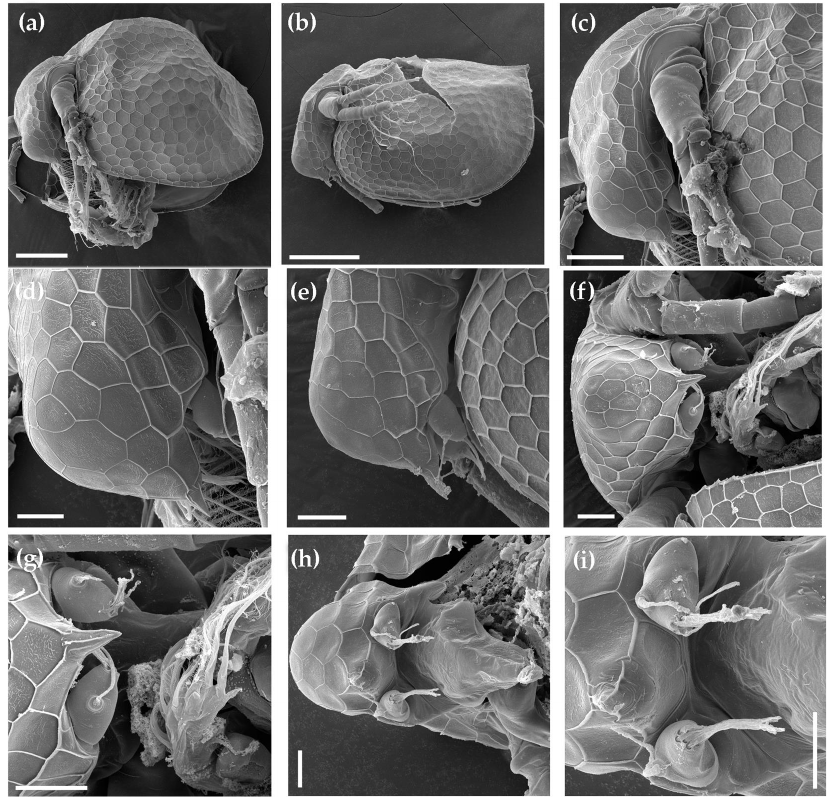
Figure 3. Ceriodaphnia cf. cornuta , adult parthenogenetic females from Masfoot Dam 1, United Arab Emirates. ( a , b ) adult females, lateral view; ( c – e ) head, lateral view; ( f ) head, ventral view; ( g ) rostrum, ventral view; ( h , i ) antenna I. Scale bars: 0.1 mm for ( a , b ), 0.05 mm for ( c ), 0.02 mm for ( d – i ).